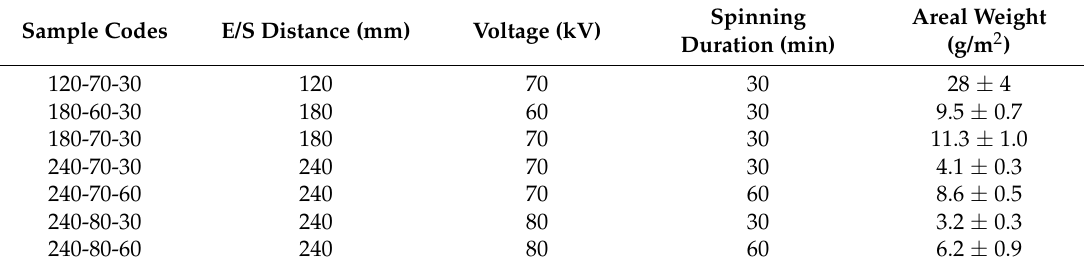
Table 1. Parameter combinations for the electrospinning process.